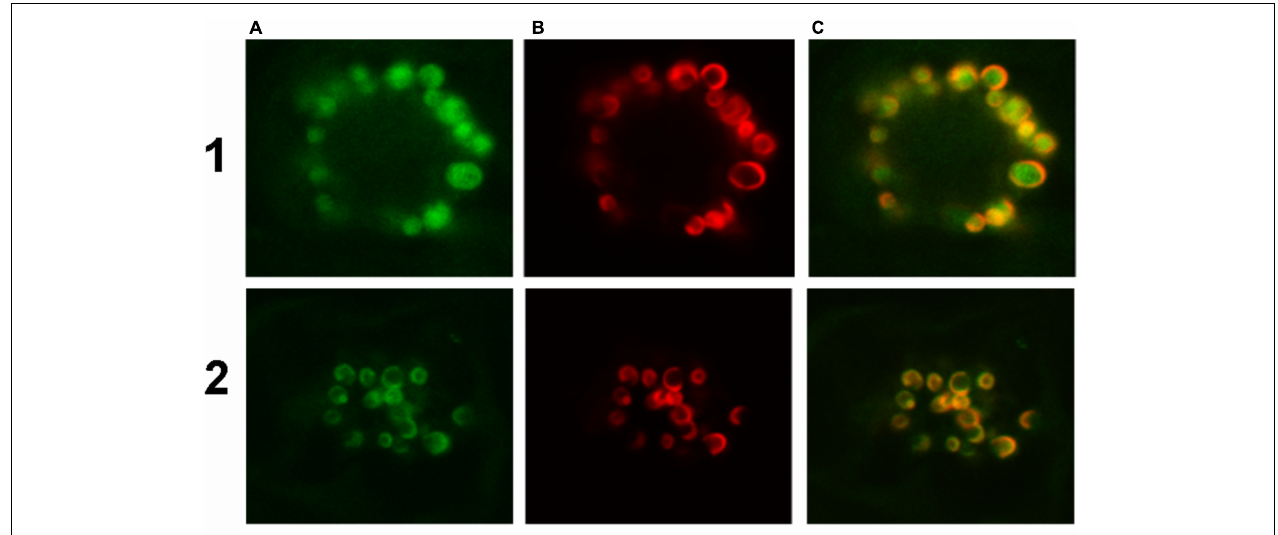
FIGURE 9 | Representative confocal laser scanning microscopy images of GFP-tagged Ha FatA or Ha FatB expressed transiently (via biolistic bombardment) in BY-2 tobacco cells. Images in column (A) show FatA-GFP row (1) and FatB-GFP row (2) , while those in column (B) represent the expression of sub-cellular marker proteins co-expressed in the same cells, specifically the inner chloroplast envelope protein Tic40-RFP. Corresponding merged images of all the cells are shown in column (C) .